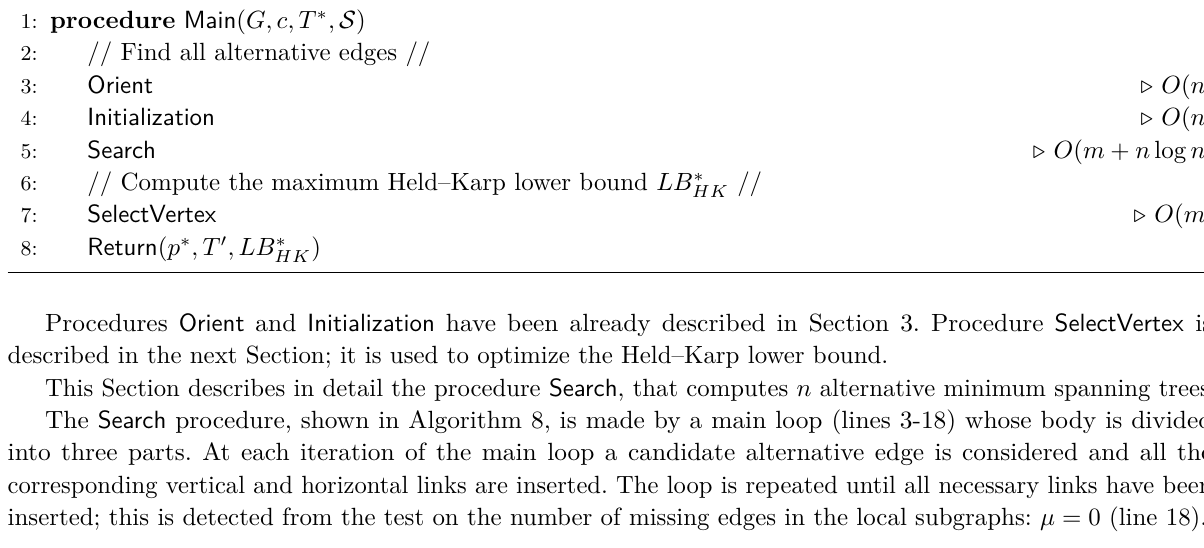
Algorithm 7 The main